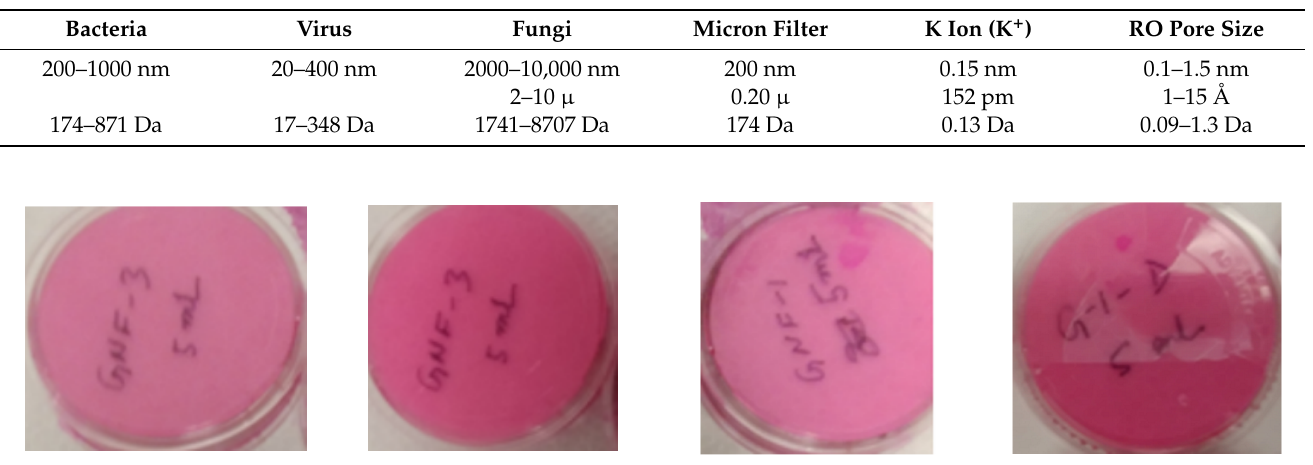
Figure 1. Cultured plates from filtration (0.2 µ m) and media culture experiments (48